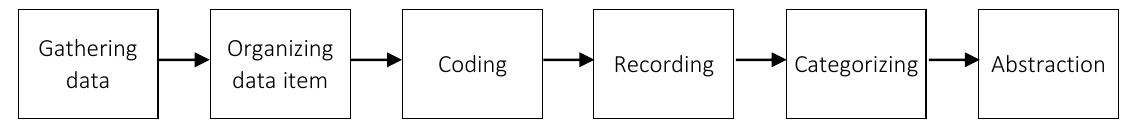
Table 1. A summary of progress of the post-2015 AEC